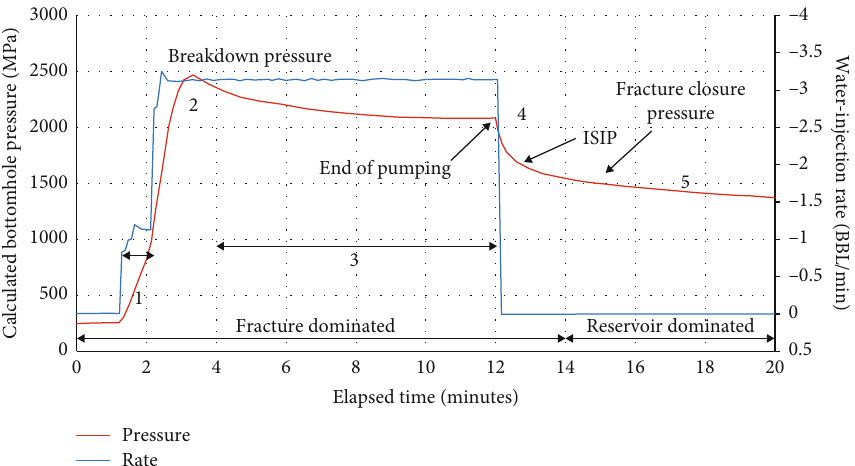
Figure 7: Typical bottom-hole pressure vs. time for DFIT test. The plotted lines represent the surface pressure (red line) and the injection rate (black line) modi fi ed after